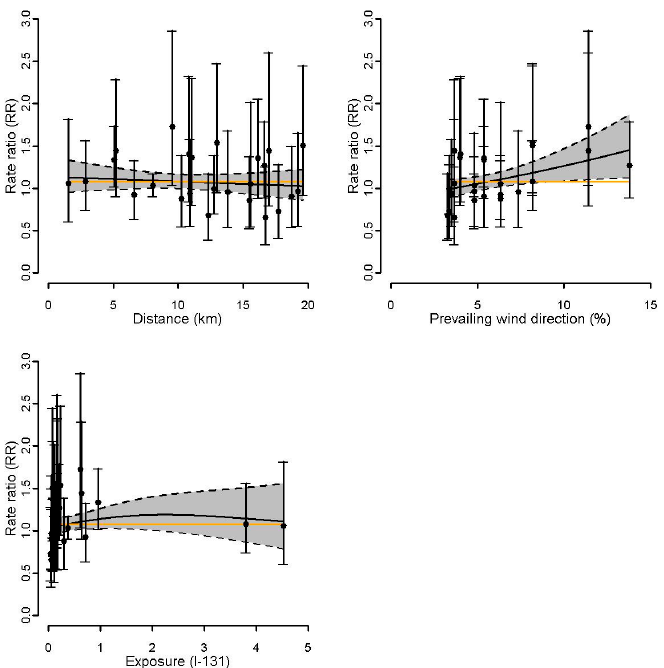
Figure 5. Fleurus: Rate ratios (RR) and 95% CI (gray area) of thyroid cancer incidence within the 20 km proximity areas as a smooth function of 1: residential proximity to the nuclear site, 2: prevailing wind directions, and 3: I-131 estimates. The orange line represents the constant RR. The dots represent the commune-specific RRs with their 95% CI.